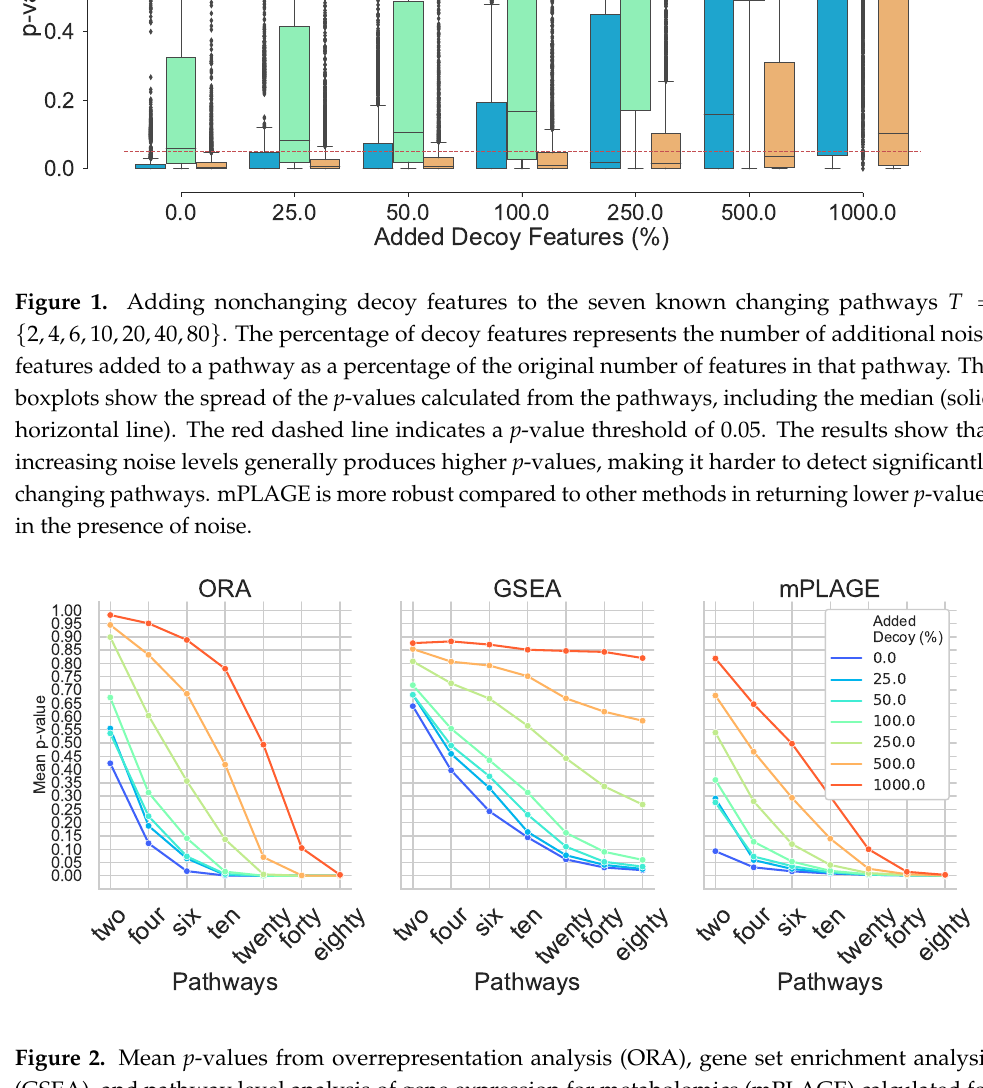
Figure 2. Mean p -values from overrepresentation analysis (ORA), gene set enrichment analysis (GSEA), and pathway level analysis of gene expression for metabolomics (mPLAGE) calculated for each significantly changing synthetic pathway at different levels of decoy features added. Across all levels of added decoy features, it is easier to identify larger pathways as significantly changing than smaller pathways. mPLAGE generally returns lower p -values than ORA and